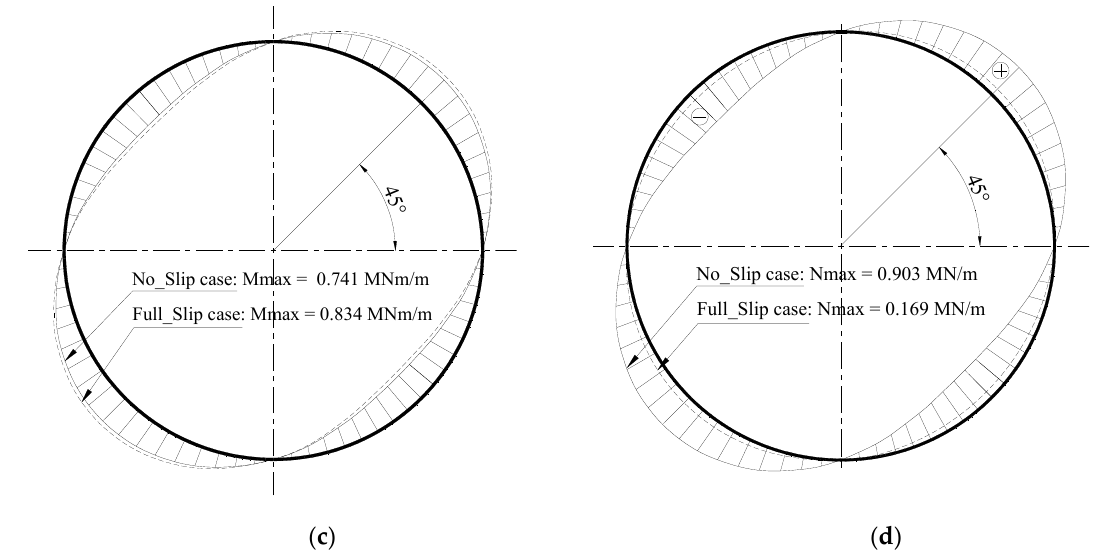
Figure 4. Distribution of the incremental internal forces in the circular tunnel by FLAC 3D and Wang solution. ( a ) Incremental bending moments; ( b ) incremental normal forces; ( c ) incremental bending moments; ( d ) incremental normal forces.